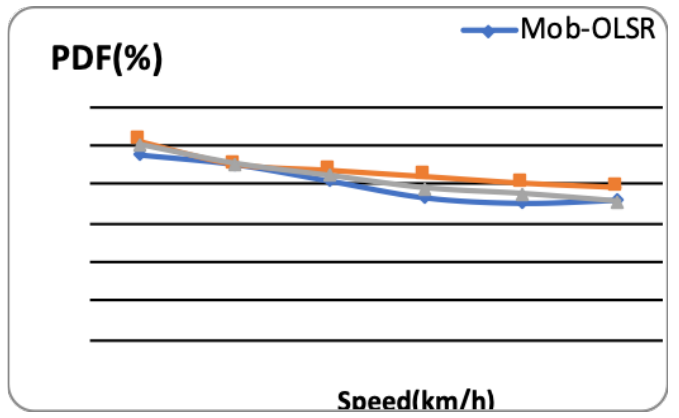
Fig. 8. PDR depending on the nodes speed